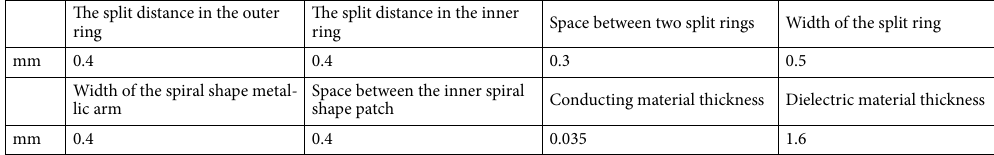
The split distance in the outer ring